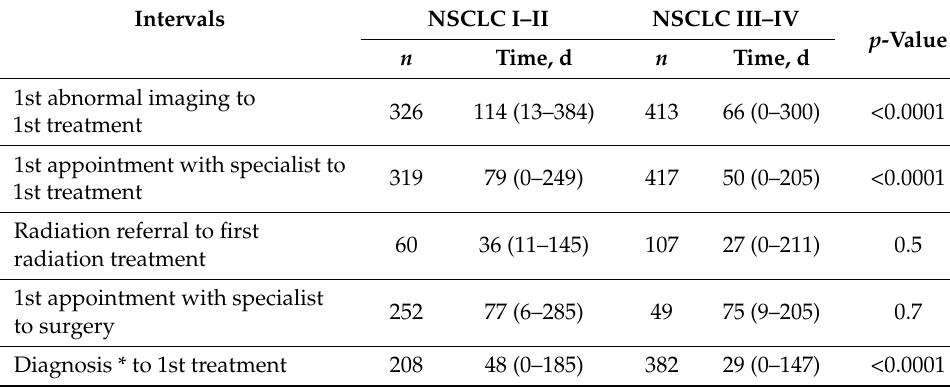
Table A1. Wait times for investigation and treatment, NSCLC stages I–II versus III–IV.